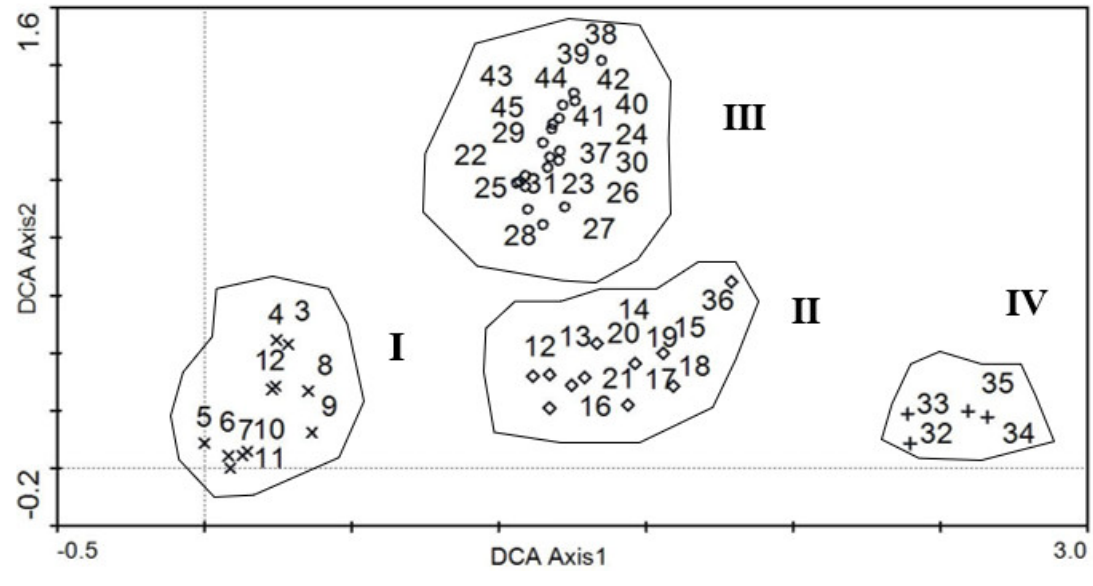
Figure 3. DCA ordination of the 45